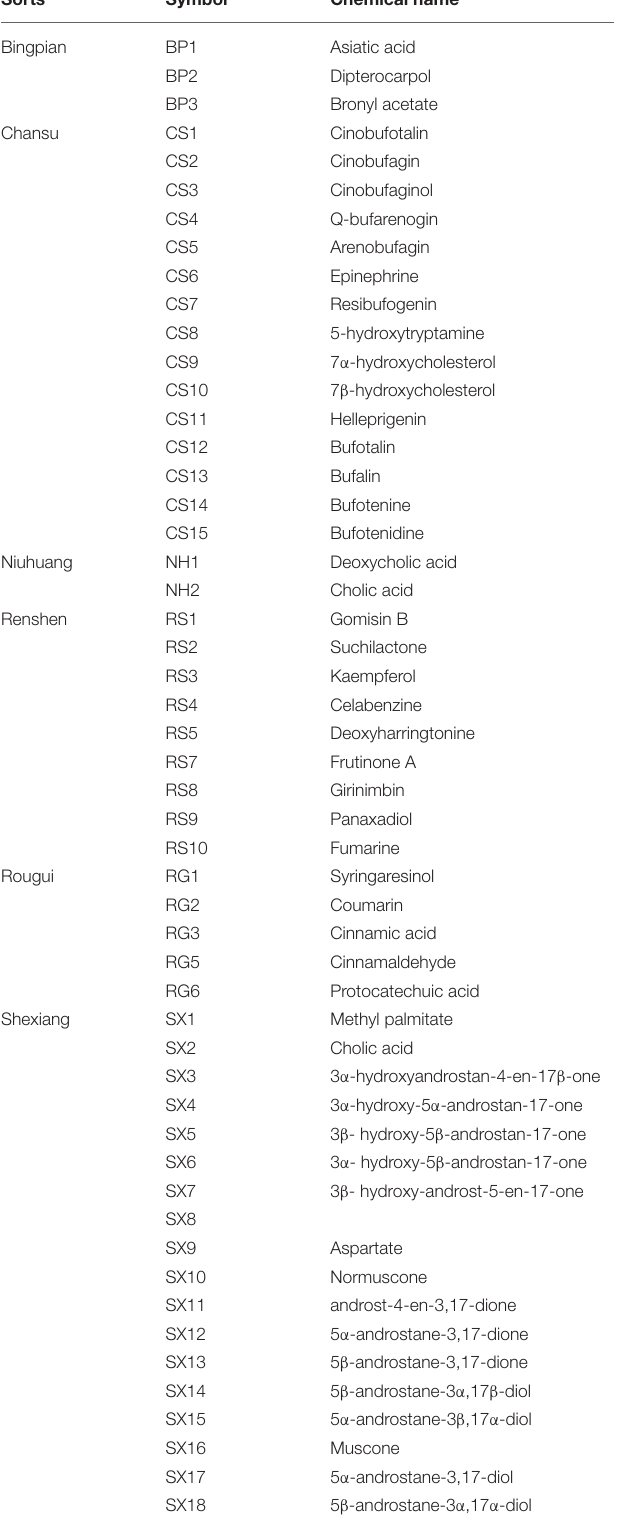
TABLE 1 | Chemical names of symbols and their sorts. Sorts Symbol Chemical name Bingpian